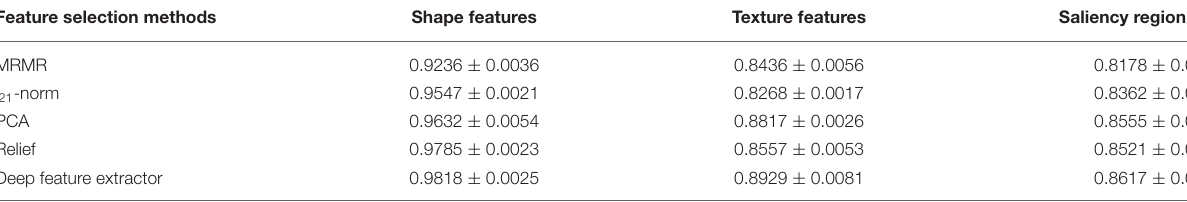
TABLE 5 | Classification performance in terms of specificity.